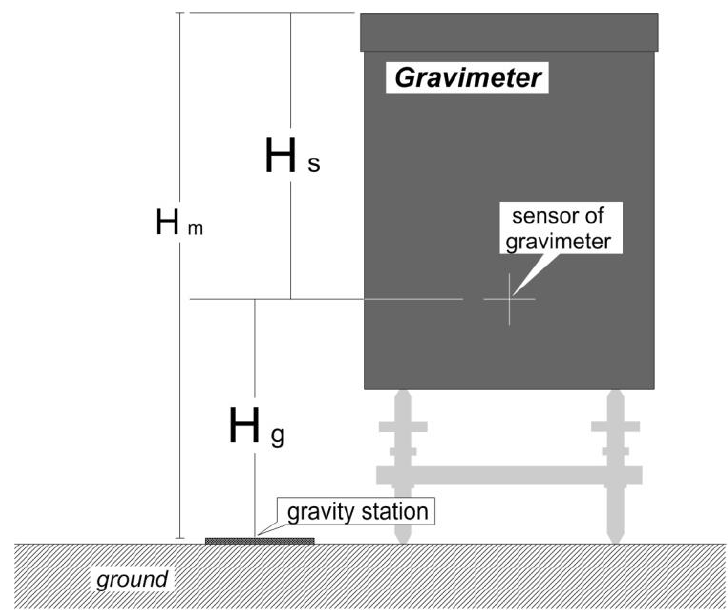
Figure 2. Graphical illustration of the meter height correction.